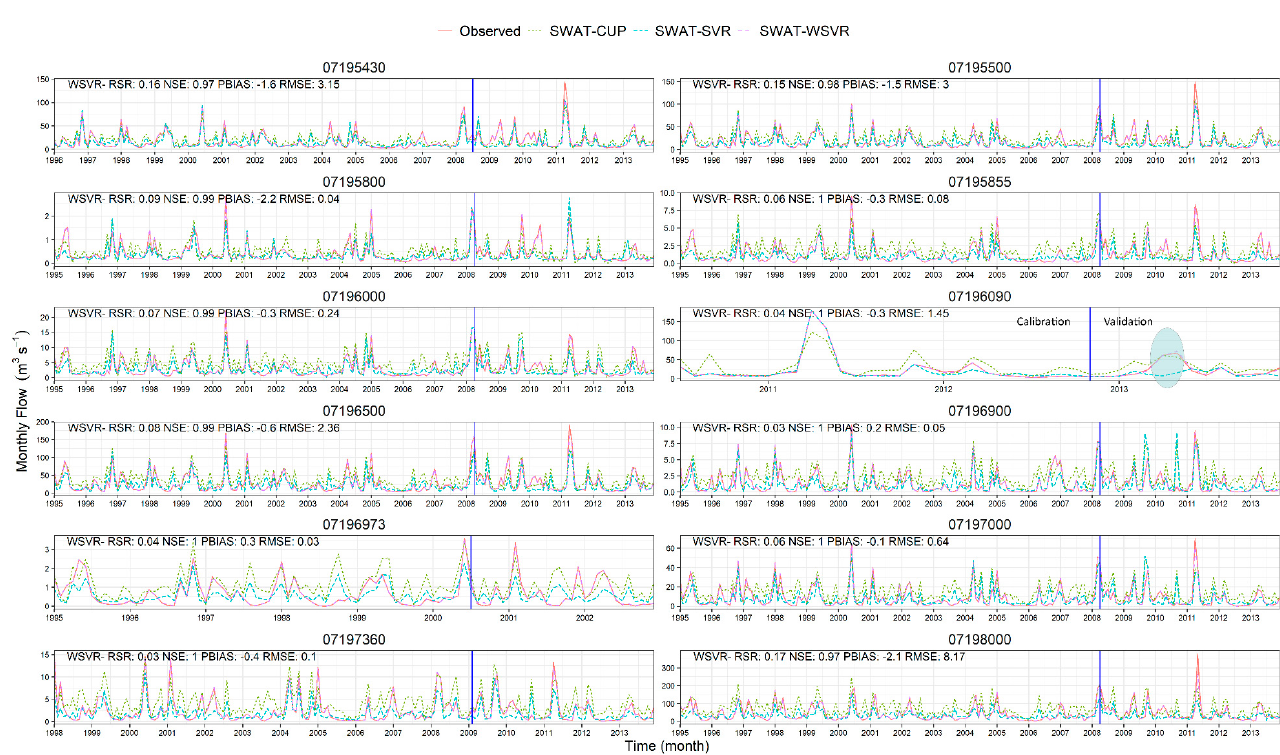
Figure 7. Comparison of SWAT-CUP, SWAT-SVR, SWAT-WSVR, and observed flow time series on each site. (Note: a vertical blue line separated the 70% training and 30% testing data. Only statistics from SWAT-WSVR were labeled for clarity.).